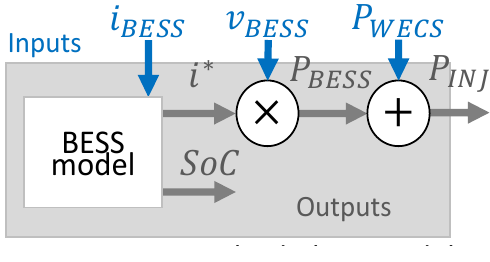
Figure 14. System inputs and